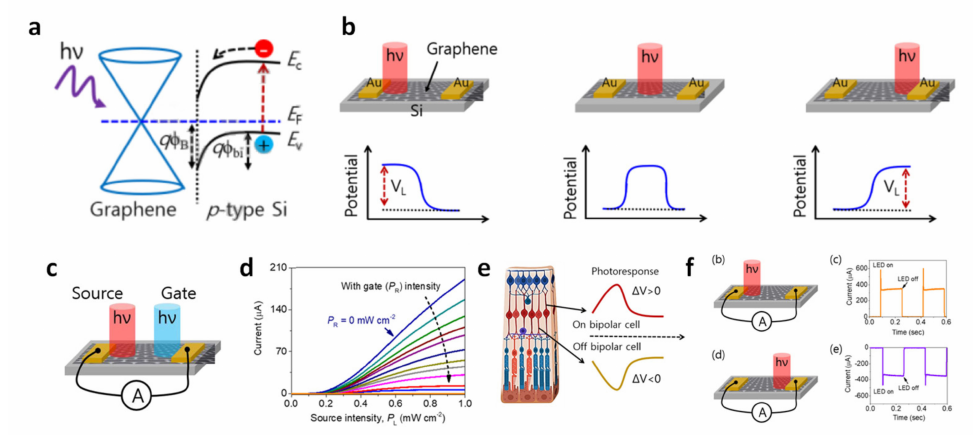
Figure 5. ( a ) Simplified energy band diagram of a graphene/p-type Si heterostructure. ( b ) The operational principle of the fabricated graphene/p-type Si device, and the location of light irradiation. ( c ) Illustration of a photon-triggered transistor (PTT) using two light sources. ( d ) The current–source light characteristic as a function of gate light intensity. ( e ) Functional schematic of the in vivo retinal information processing system. ( f ) A two-terminal device, illuminating the left- and right-electrode sides. The illumination conditions were λ = 420 nm, 2 mW cm − 2 . Reproduced with permission from [66], Copyright 2020,